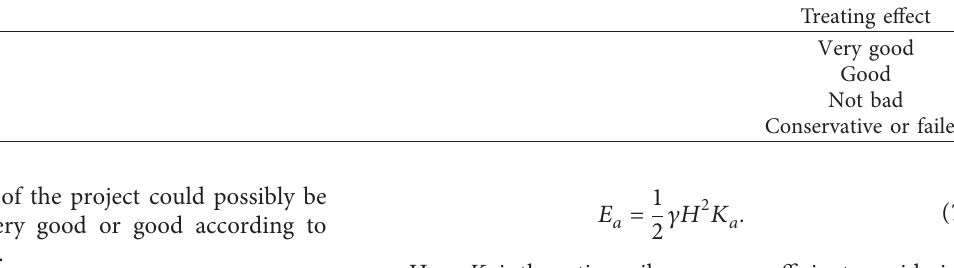
Table 4: Ratio of the measured force and the designed force ( R Indicator value range 0.6 ∼